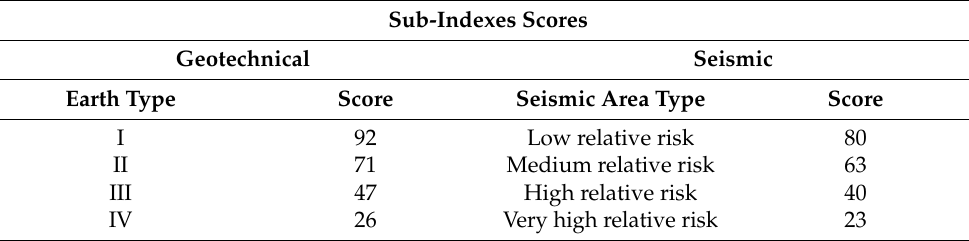
Table 14. Scores of sub-indexes in geotechnical and seismic index.